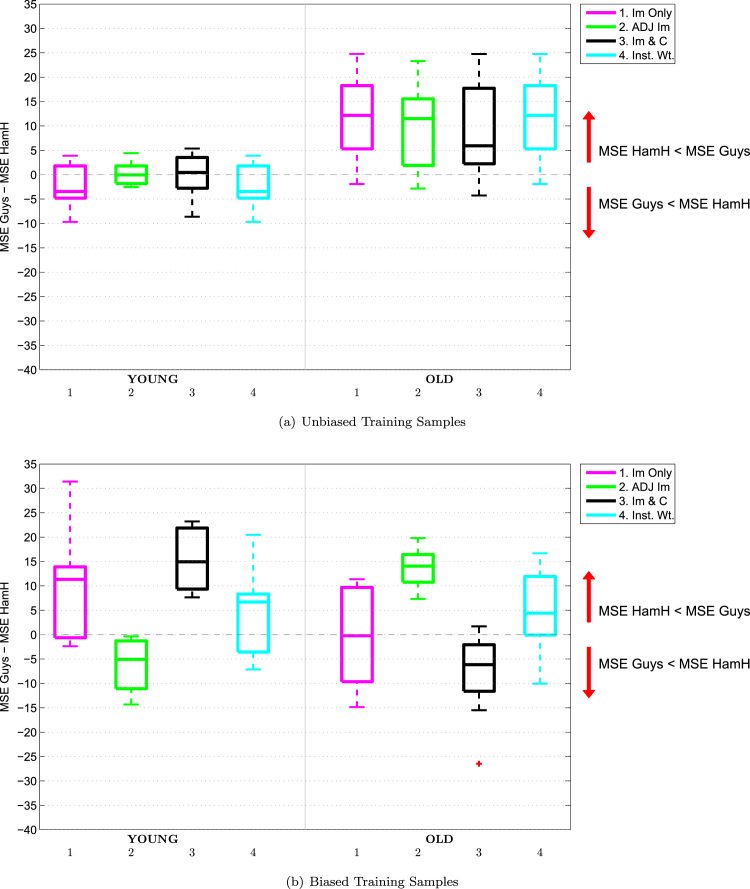
Signed difference between the MSE for Guys and Hammersmith subjects, over the different ranges of age. The data points in each box plot are the 8 predictions performed for a particular model. Results using unbiased training samples are shown in (a), while results using biased training samples are shown in (b). In the biased samples, subjects from Guys tend to be older.